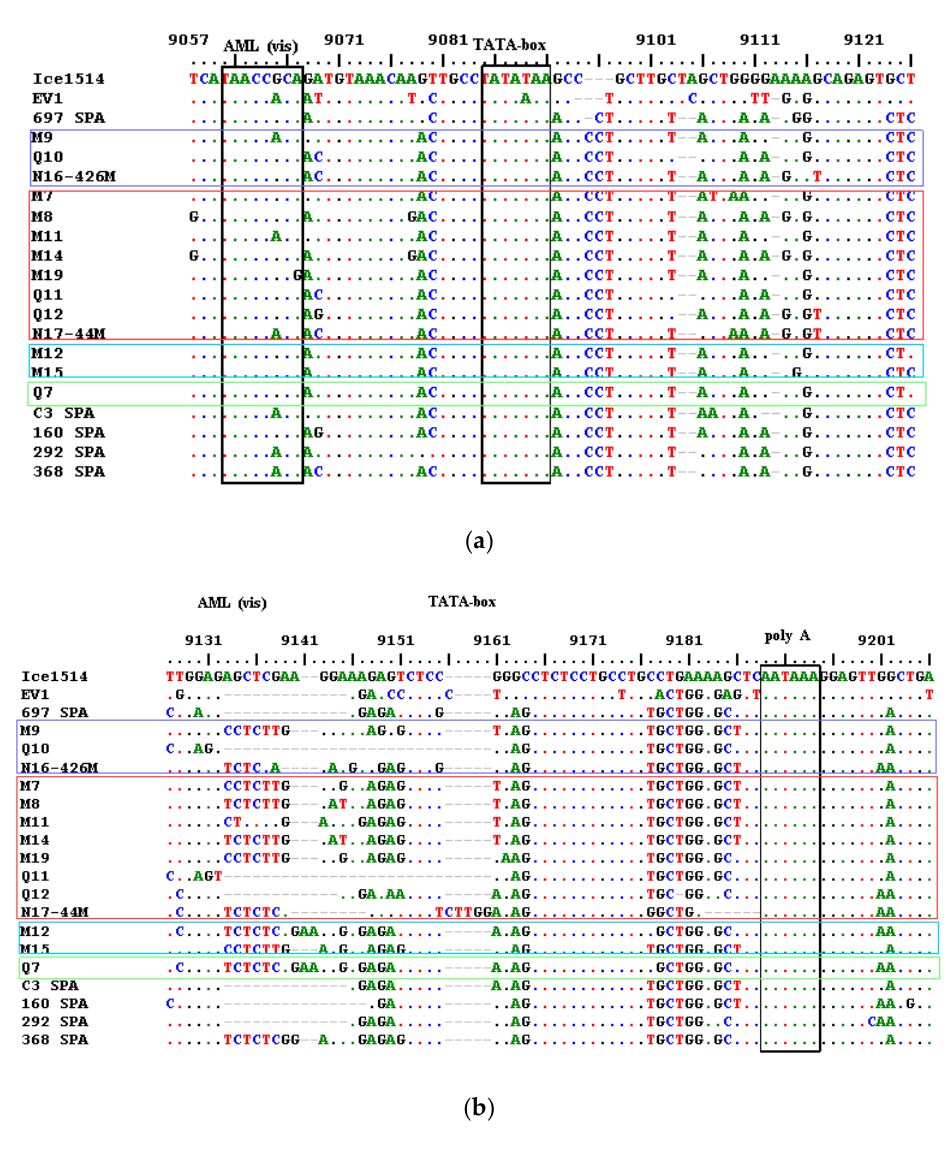
Figure 6. Alignment (MUSCLE) of nucleotide sequences of the LTR region of the SRLV sequences obtained and of some SRLV reference strains. LTR sequence of the isolate Icelandic 1514 (M10609.1) was used as a reference; ( a ) positions from 9057 to 9126, ( b ) posiions from 9127 to 9206. Sequence of reference strains EV1 (S51392.1) was also used. Sequences previously found in Spain in goats (C3—DQ084355.1) and in sheep (697—HQ864615.1, 160—HQ864610.1, 292—HQ864611.1 and 368—HQ864614.1) and showing high homology with our samples were also included. Sequences of the AML (vis), the TATA box element, and the polyadenylation signal are within black squares. Sequences of samples with similar scores of mammary lesions are within colored squares. Legend: ( · ) homology, ( − ) deletion, (blue squares) severe lesions, (red squares) moderate lesions, (light blue squares) minimal lesions, and (green squares) no lesions.